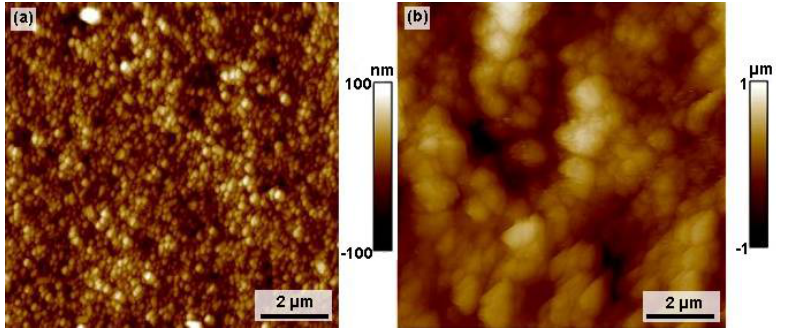
Figure 5. AFM analysis of the surface morphology and roughness: ( a ) analysis of Alfiflon 39—Ra = Figure 5. AFManalysisofthesurfacemorphologyandroughness: ( a )analysisofAlfiflon39—Ra = 17.8 nm, 17.8 nm, RMS = 12.8 nm and ( b ) analysis of Alfipas—Ra = 180 nm, RMS = 232 nm. RMS = 12.8 nm and ( b ) analysis of Alfipas—Ra = 180 nm, RMS = 232